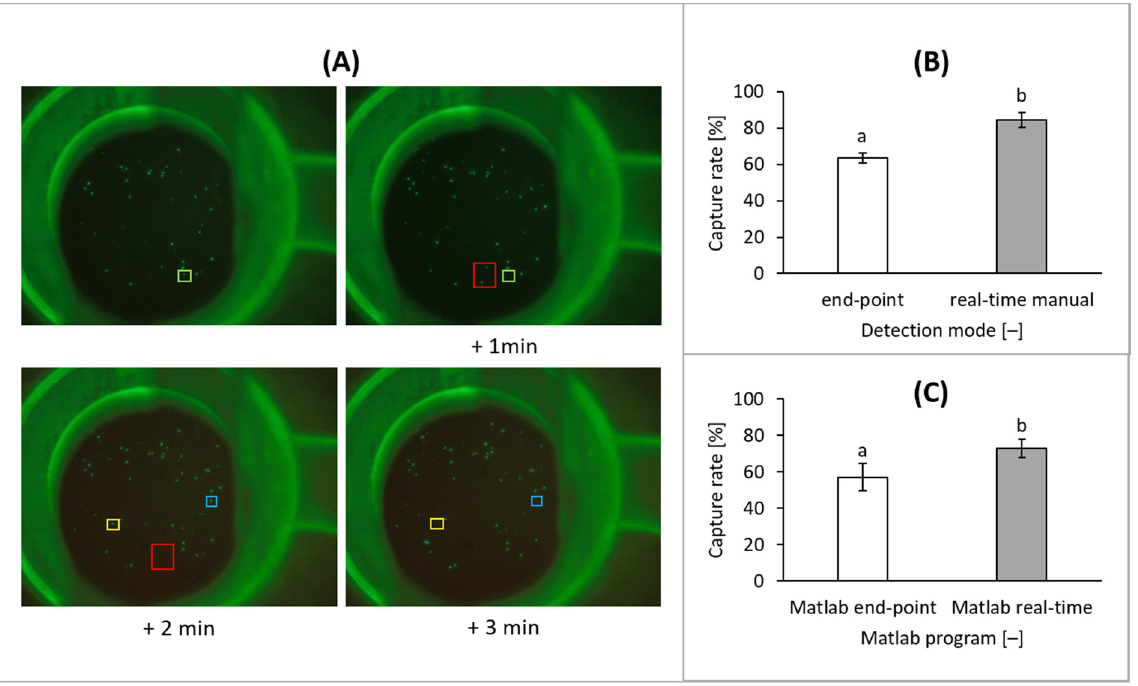
Figure 11. CFSE-stained cells in 1 × PBS/1% BSA/1 mM EDTA detected in real-time during filtration. ( A ) The filtration process was imaged every minute in order to maximize the number of observed cells despite some cells passing the filter. ( B ) Cells were counted manually during filtration and after the filtration process ( n = 5). ( C ) Cells were counted using the custom Matlab program using the end-point image and in real-time ( n = 5).